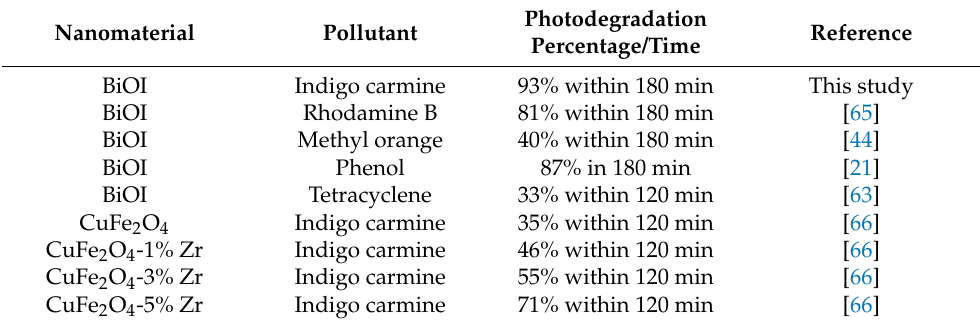
Table 1. Compares the photocatalysts’ photodegradation with the sonochemically fabricated BiOI in this